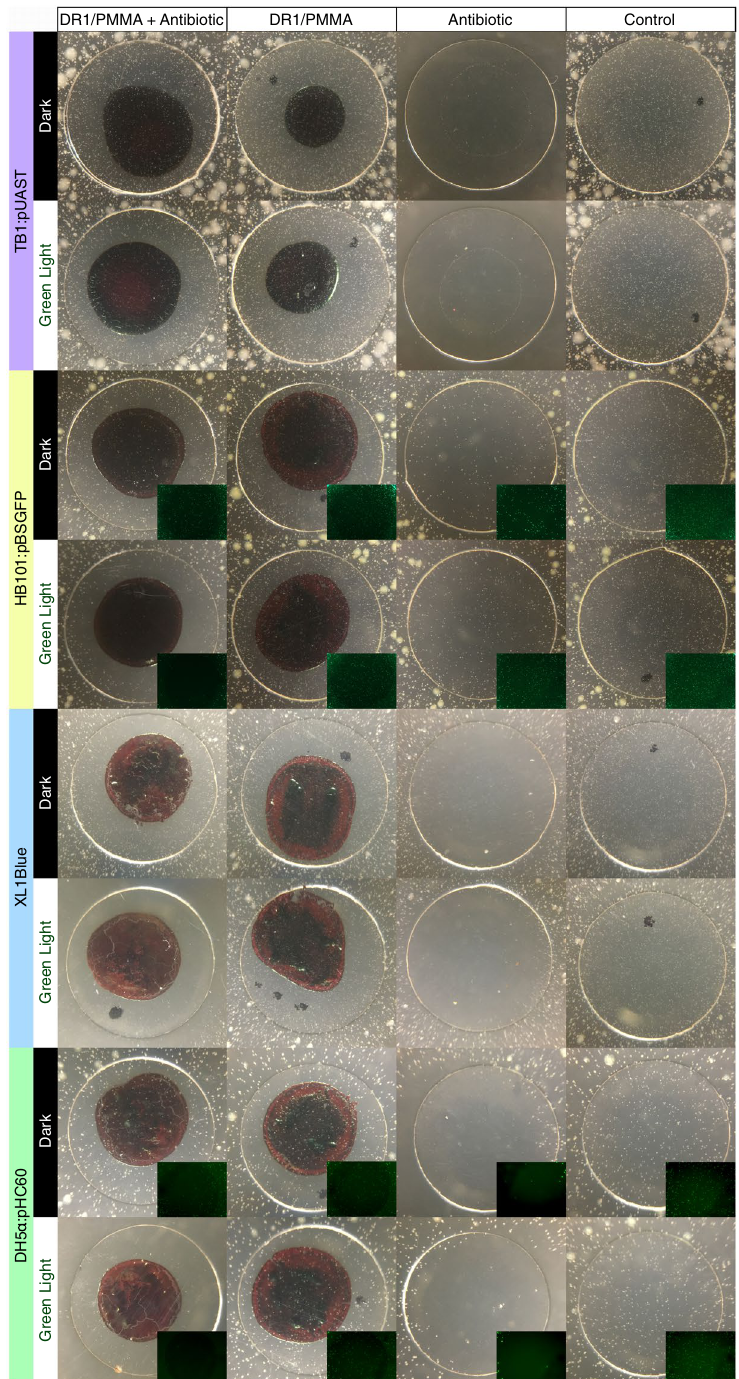
Figure 4. Antibiotic release by exposure to green light. Negative control coverslips (Control) have neither antibiotic nor DR1/PMMA. 0.625 µ g tetracycline (top four rows) or 2.5 µ g ampicillin (bottom four rows) was applied to the positive control coverslips (Antibiotic). 600 µ g DR1/PMMA was applied to no antibiotic control coverslips (DR1/ PMMA). 0.625 µ g tetracycline (top four rows) or 2.5 µ g ampicillin (bottom four rows), and 600 µ g DR1/PMMA was applied to the experimental coverslips (DR1/PMMA + Antibiotic). See Fig. 1 to identify